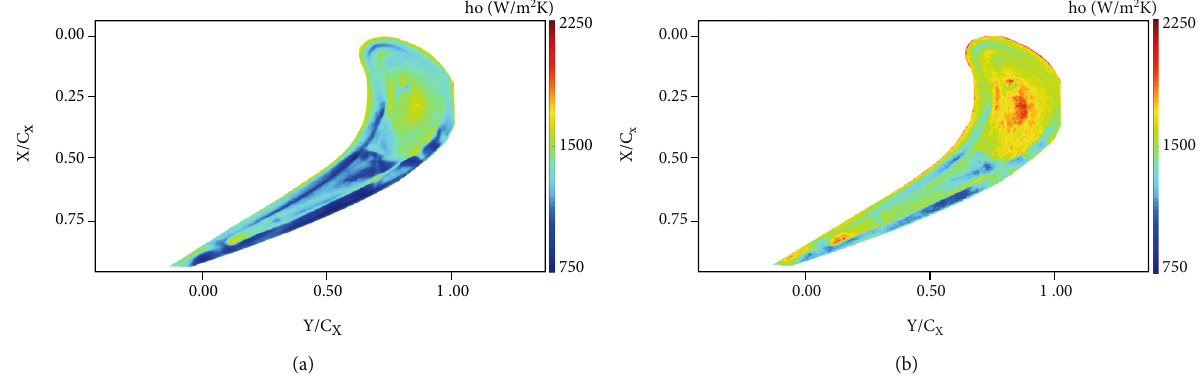
Figure 5: Baseline heat transfer coe ffi cient ratio data along the squealer tip surface without fi lm cooling. (a) Dataset 8, 0.8mm tip gap. (b) Dataset 1, 1.4mm tip